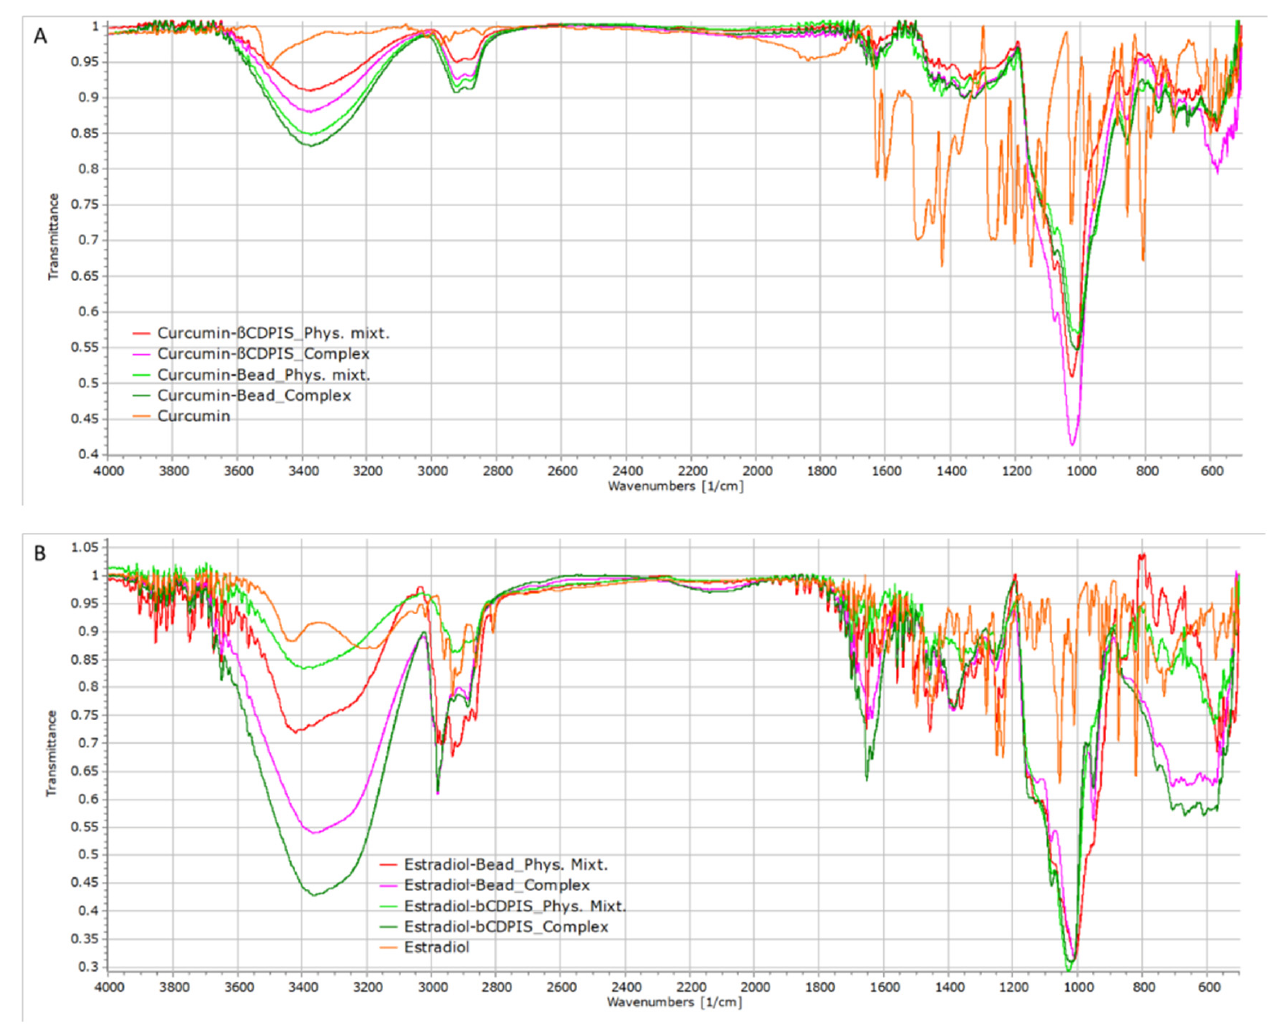
Figure 6. IR spectra of pure APIs, physical mixtures, and complexes with ( A ) curcumin and ( B ) estradiol. The mechanochemically synthesized insoluble polymer contains fewer hydroxyl groups than the bead polymer because hydrolysis of epichlorohydrin during synthe- sis is limited. The nearly relative identical OH/H-bond (3200–3500 cm − 1 ) and water (1610–1660 cm − 1 ) regions (Figure S3) are in contrast to the C-O/C-C (1000–1100 cm − 1 ) region which is significantly larger in β CDPIS. The complex preparation increased the water content of the polymers in complexes, as shown by the higher intensities of the hydro- gen bond OH region (3200–3500 cm − 1 ). Interestingly, a phenolic OH signal (>3580 cm − 1 ) appeared in the β CDP, suggesting some residual uncomplexed curcumin on the β CDP surface. The similar signal of estradiol completely disappeared in the physical mixture of β CDP and complexes. The higher water content of complexes resulted in a further signal reduction in the 1600–1700 cm − 1 region, where the water signal suppresses some aromatic bands. While the aromatic vibrations are visible in the spectrum of the synthetic physical mixture, these signs of guest molecules are often invisible in the recorded spectra of the physical mixture, and even more so in the complex. Because this region overlaps with the aromatic vibrations of both guest molecules, the effect of complexation to the aromatic moieties remained hidden. Although the C-H stretching bands (2750–3000 cm − 1 ) in the estradiol cases showed significant peak shifts, these moved below the twin peaks. The curcumin samples showed significant peak shifts (3–20 cm − 1 ), indicating the modification of the H-bond networks in the